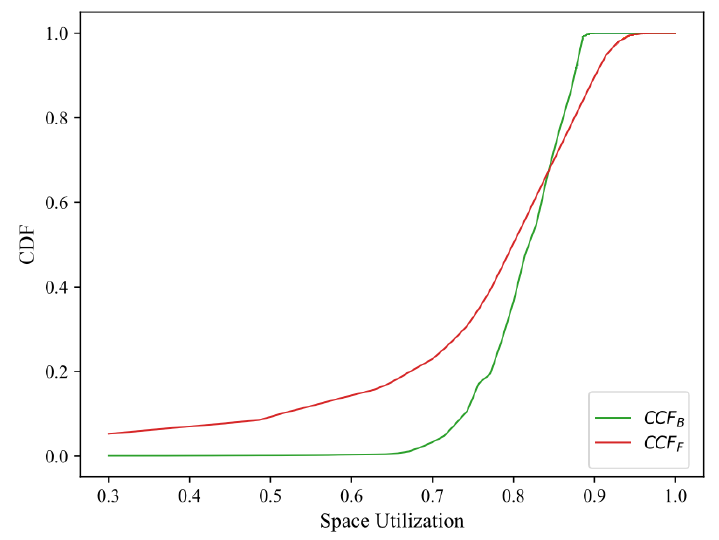
Figure 6. CDF of space utilization of CCF F and CCF B under the same